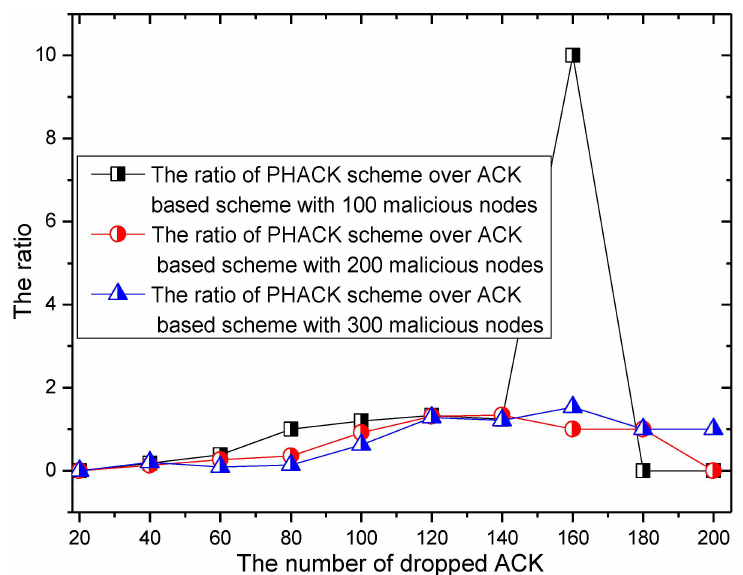
Figure 14. The number of dropped ACKs.